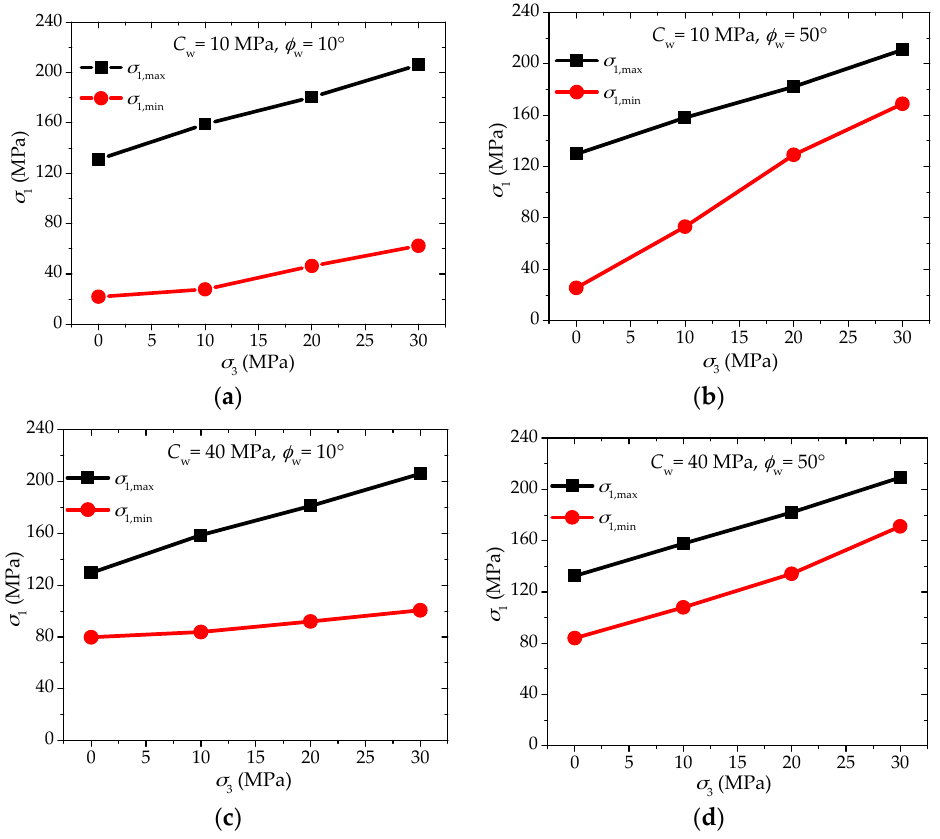
Figure 13. Four typical behaviors of maximum and minimum strengths with increasing confinement dominated by different combinations of cohesion c w and friction angle φ w of the weak planes based on numerical analyses. ( a ) c w = 10 MPa, ϕ w = 10 ◦ ; ( b ) c w = 10 MPa, ϕ w = 50 ◦ ; ( c ) c w = 40 MPa, ϕ w = 10 ◦ ; and ( d ) c w = 40 MPa, ϕ w = 50 ◦